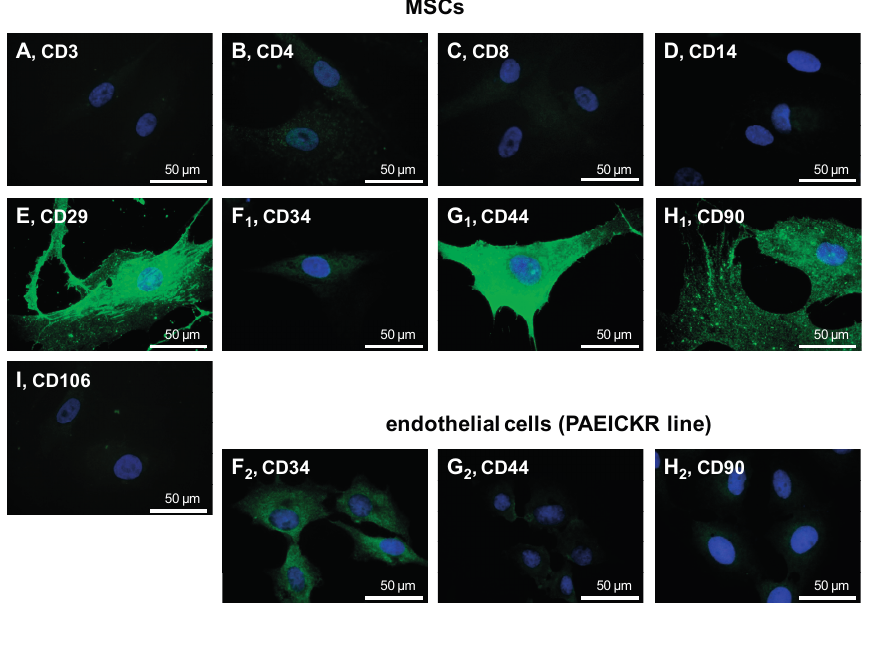
Figure 2. Characterization of MSCs surface marker expression (passages 4–6) using fluorescence microscopy. Surface markers such as leukocyte surface proteins CD3 ( A ); CD4 ( B ); CD8 ( C ); CD14 ( D ); cell adhesion protein CD29 ( E ); endothelial cell marker CD34 ( F , F ); hyaluronan receptor CD44 ( G , G ); mesenchymal cell marker CD90 1 2 1 2 , H ); and CD106 ( I ) are depicted by immunofluorescence microscopy (green). ( H 1 2 Cells of the human endothelial cell line PAEICKR were immunolabelled for CD34 ( F CD44 ( G ) and CD90 ( H ) as a control. Cell nuclei were counterstained using 4',6-diamidino- 2 2 2-phenylindole (DAPI, blue). Scale bars = 50